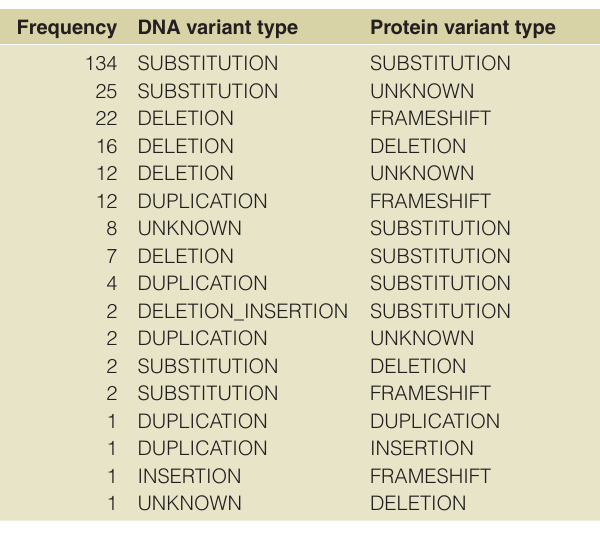
Table 17. InSiGHT database variants, taking into account the DNA variant and the impact on the gene product. Variants have been annotated using SETH, thus the variant types delivered by SETH are